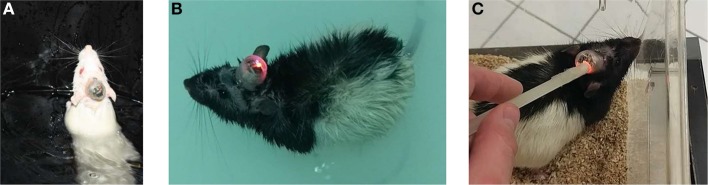
Photographs show the device operating inside the water-maze for Sprague Dawley (A) and Long Evans (B) rats. Devices were activated inside either the home-cages or the water-maze room, using a magnet (C).